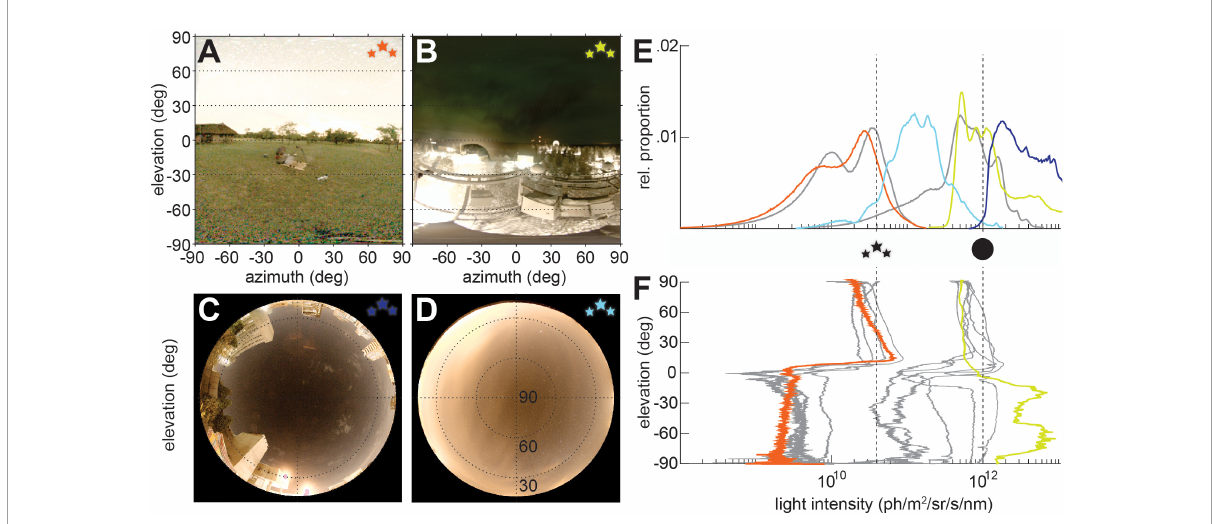
FIGURE2 Nocturnal visual scenes with light pollution. (A–D) Nocturnal visual scenes on moonless nights with different types of light pollution. (A) Starry sky in rural Limpopo (24 ◦ 43 (cid:48) 46 (cid:48)(cid:48) S, 27 ◦ 57 (cid:48) 06 (cid:48)(cid:48) E), South Africa with sky glow visible at the horizon. (B) Nocturnal scene in Sodankylä, Finland, showing a weak aurora borealis in the sky, and direct light pollution relfected by the snowy ground below the horizon. (C) Sky at the University of the Witwatersrand, South Africa, with direct light pollution from surrounding buildings, and (D) sky in Östra Odarslöv, Sweden, showing clouds lit up by sky glow. Lines in panels (C,D) indicate 60 and 30 ◦ elevation. (E) The relative proportion of pixel intensities [colors correspond to those of the star icons for scenes depicted in panels (A–D) , with the average intensity profiles for starlight and moonlight from Figure 1E in gray] and the (F) average pixel intensies across scene elevation [the elevation intensity profiles from Figure 1F in gray, and the elevation profiles of the scenes in panels (A,B) in